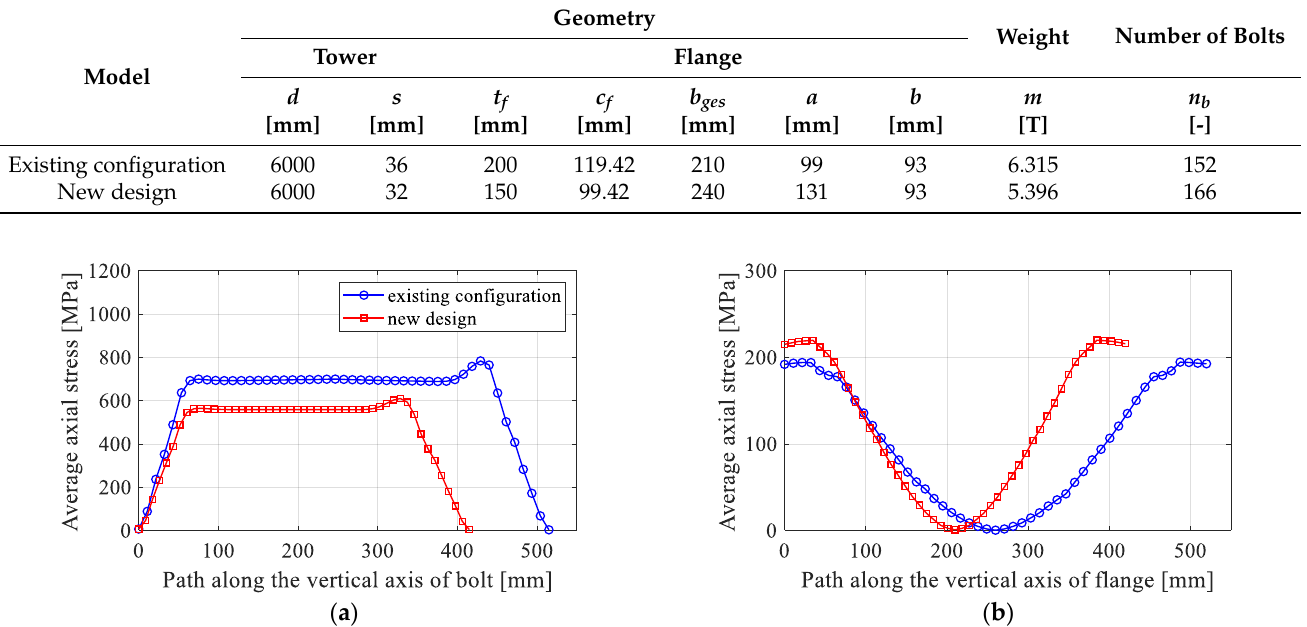
Figure 12. Stress distribution under design load: ( a ) bolt and ( b ) flange.